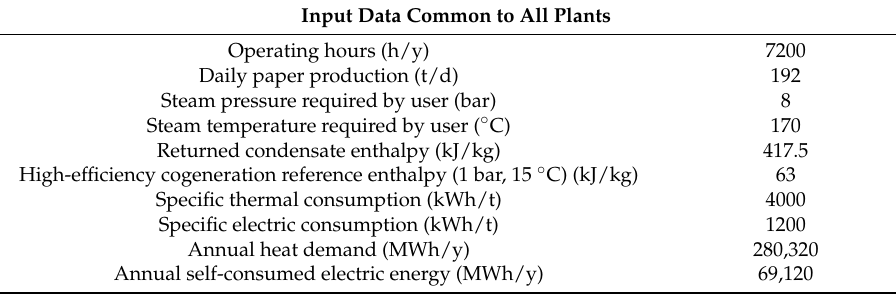
Figure 1. Typical day load diagram. It shows the electric and thermal power demand with values assumed to be constant over a period of 1 h. Table 3. Input data common to all plant types.